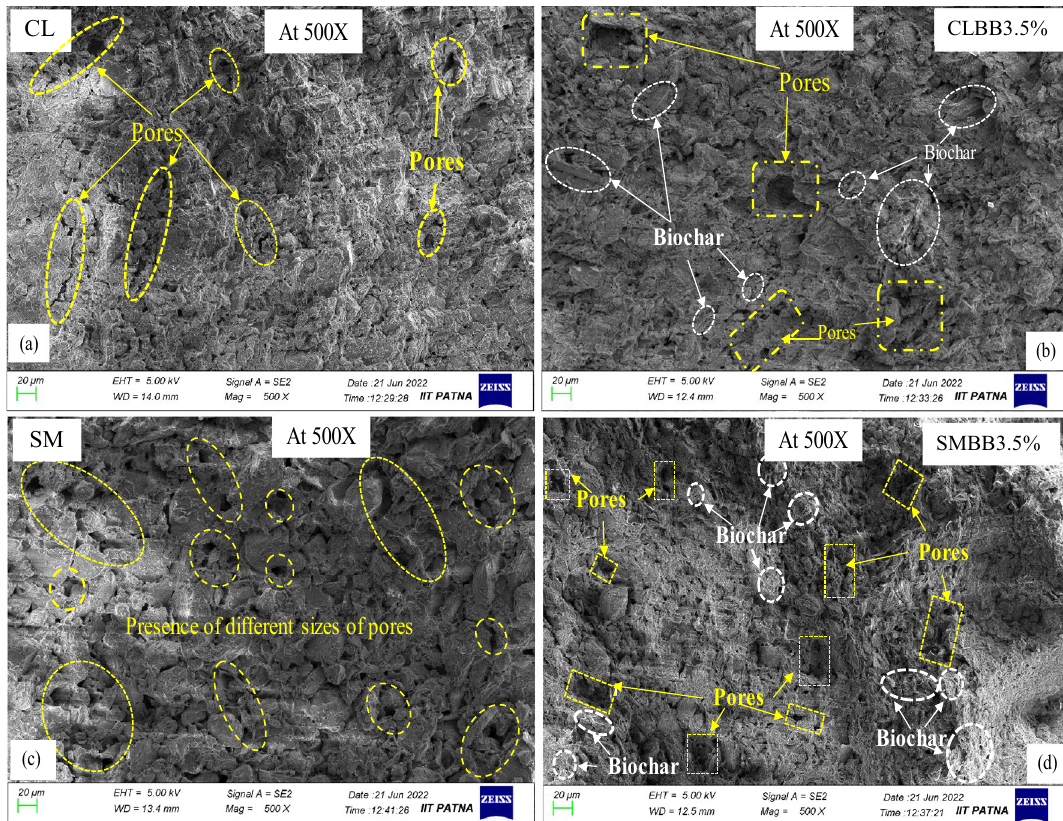
Figure 10. The change in number of pores and size in the surface morphology of WP4C specimens at 500 magnification: for ( a , c ) non amended CL, SM soil; and ( b , d ) CL, SM soil mixed with 3.5% (w/w) biochar